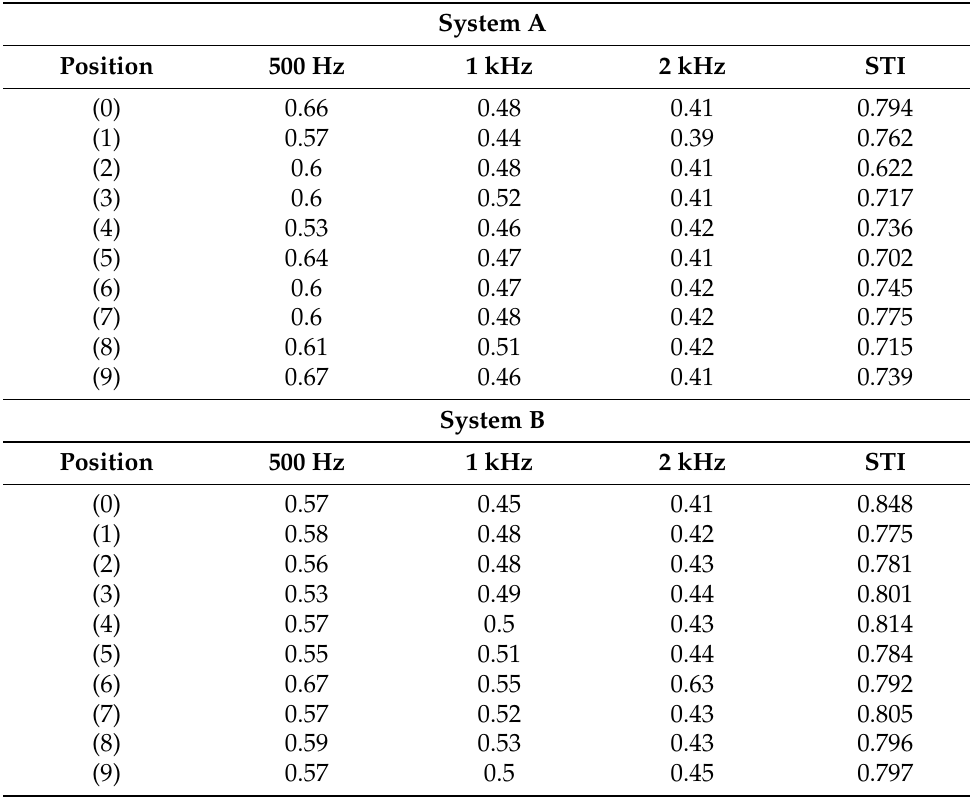
Table 4. RT (s) for octave bands with centre frequencies 500 Hz, 1 kHz, and 2 kHz (in accordance with the American standard [57]), and STI for the two systems. The measurement positions are indicated in Figure 3